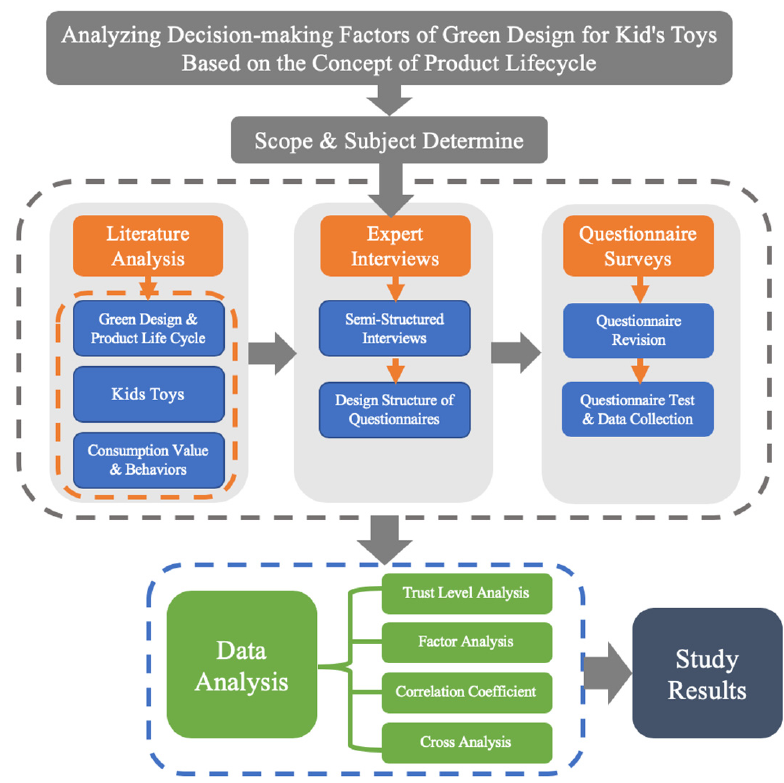
Figure 2. Research structure (Source: compiled by this research).